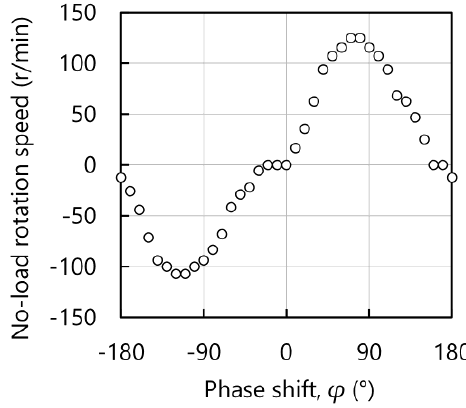
Figure 8. No-load rotation speed as a function of the phase shift of the voltages applied to torsional and flexural vibrations. The voltages applied to the flexural and torsional PZT disks have the phase shift φ .